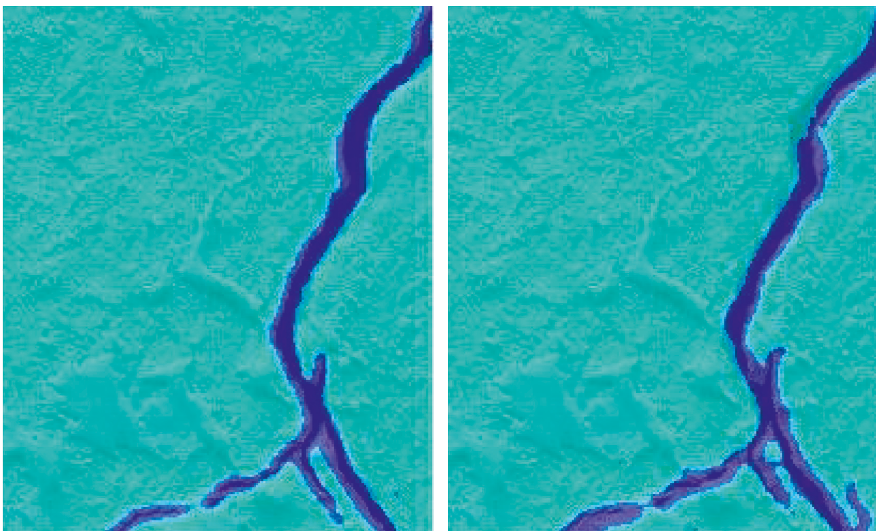
Figure 5: Partial enlargement of FCN-8s and new network fracture detection